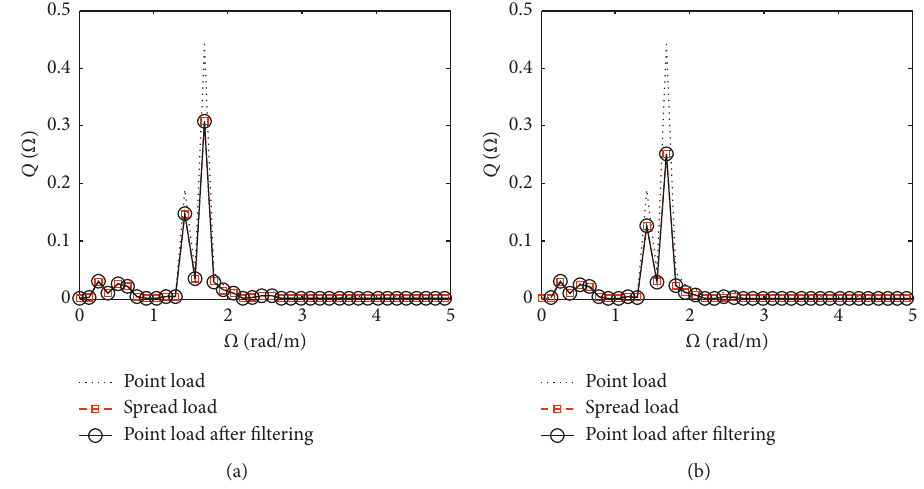
Figure 9: Bridge acceleration spectrum at resonance speed (ML model). (a) EC block load. (b) Triangular load.